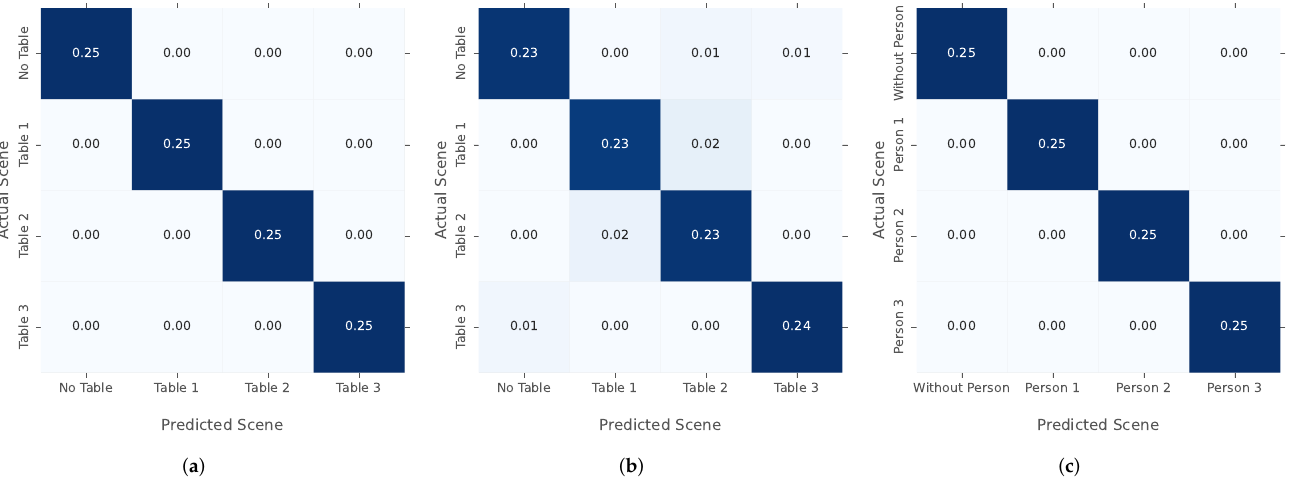
Figure 14. Confusion matrix for the classification: ( a ) table detection in the anechoic chamber (I a); ( b ) table detection in the lab mockup (II a); ( c ) seat occupancy detection in the anechoic chamber (III). To further challenge the kNN algorithm, the number of features for some datasets is extended. For this reason, the table detection dataset is extended with scenes, where multiple tables are in use. Datasets I b and II b are the extended versions of the table detection in the anechoic chamber to six classes, or in the lab mockup to eight scenes. These additional classes also cover the detection of multiple tables in use at the same